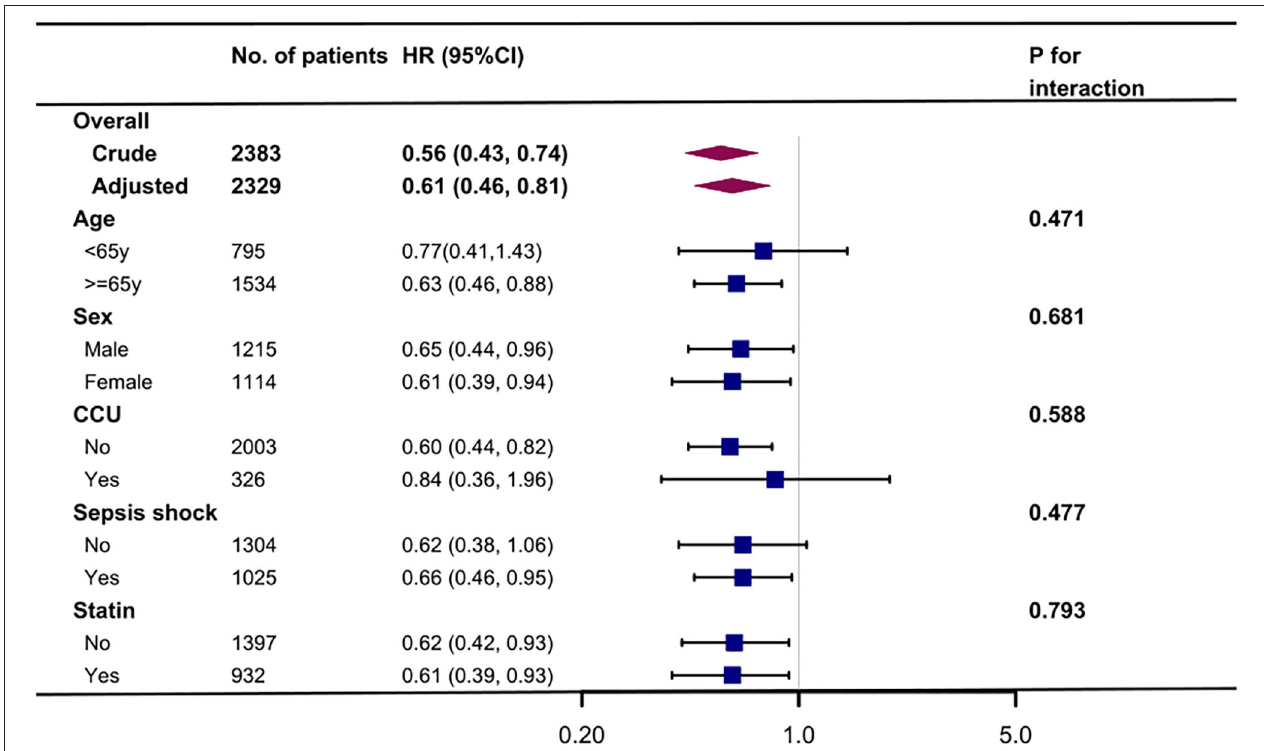
FIGURE 3 | Association between preadmission metformin use and 30-day mortality according to baseline characteristics. Each stratification adjusted for all the factors (age, sex, ethnicity, marital status, insurance, admission type, service unit, heart rate, MAP, respiratory rate, SPO 2 , WBC, SCr, hemoglobin, platelet, ventilator use, vasopressor use, comorbidity disease, and SAPS II) except the stratification factor itself. CCU, coronary care unit.